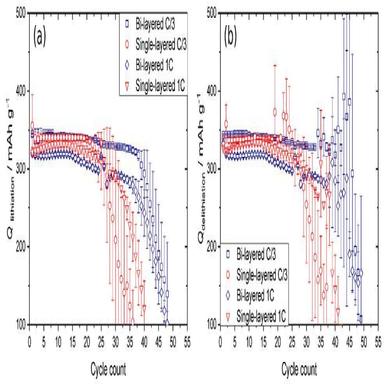
Cycling performance of HCCs consisting of single- and bi-layered graphite electrodes at C/3 and 1C between 1 V and 10 mV. (a) Lithiation and (b) delithiation. Error bars indicate standard deviation between the different cells tested.